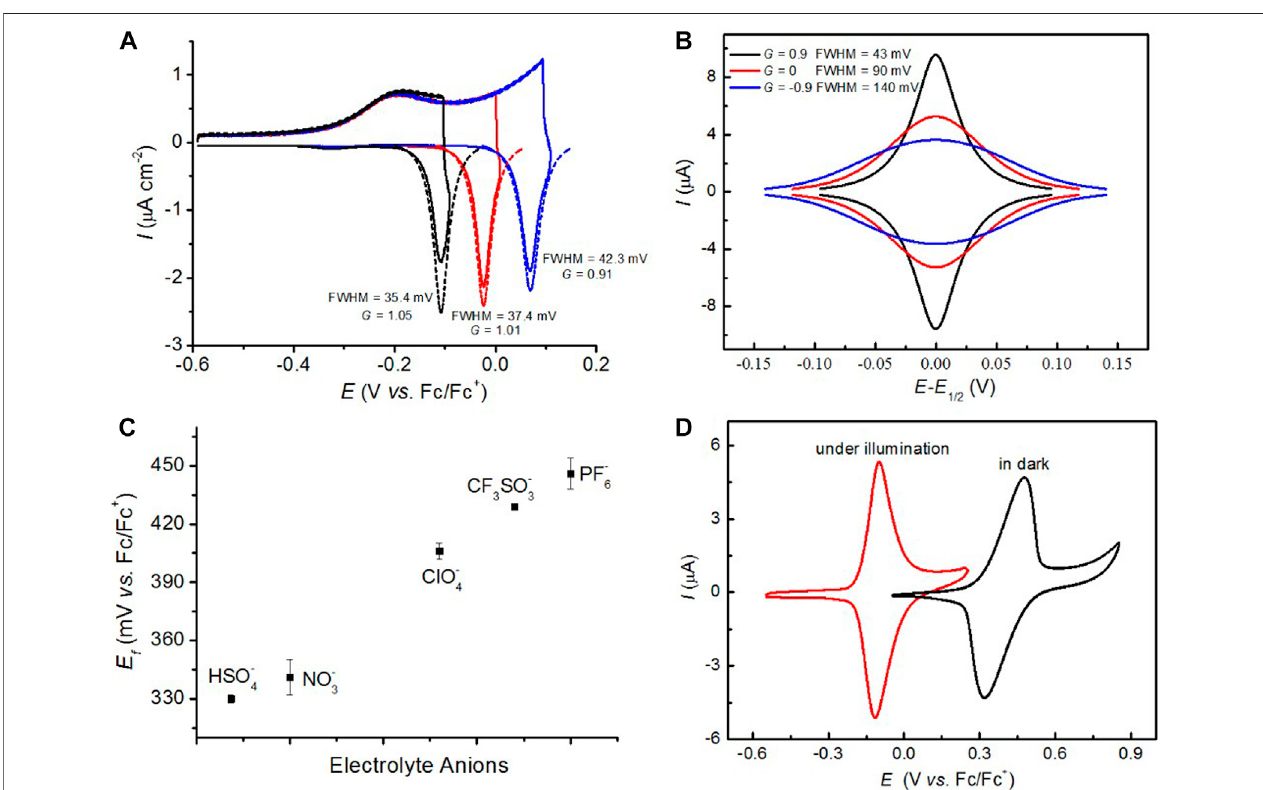
FIGURE 1 |(A) Anon-ideal “ peak inversion ” voltammogram isinduced on the TEMPO monolayer modi fi ed poorly doped Si(100) electrode when the illumination is switchedoffattheanodicvertex(0.4,0.5,or0.6 V)in0.1 Mdichloromethane/tetrabutylammoniumperchlorate(DCM/TBAClO 4 ).ThesimulatedCVs(symbol),calculated FWHMvalues,and re fi ned self-interactionparameter G arealso indicated. (B) Simulated CVs forareversible one-electron redox couplewhereboth species arestrongly adsorbed on the electrode surface. The Frumkin “ G ” term that leads tothe isotherm under equilibrium is varied between − 0.9 and 0.9, suggestingthe extent of the electrostatic interactions can be parametrized by simply introducing changes to the Frumkin G factor. The electrode area is set to 0.28 cm 2 , surface coverage is 2 × 10 − 10 mol cm − 2 ,andthevoltagesweeprateis100 mV s − 1 . (C) Shiftsoftheexperimental E 0 f asafunctionoftheLewisbasicityoftheelectrolyteanions.Theexperimental valuesof E 0 f areobtainedfrom the CVdata oftheTEMPO monolayer inacetonitrilesolutioncontainingdifferenttetrabutylammonium salts. Theindicatederror bars were calculated based on 95% con fi dence limit of the mean with six repetitive measurements for each electrolytic system. (D) CVs for TEMPO prepared on lowly doped Si(100) electrodes: redox waves in dark (black line) and their underpotential shifts under illumination (red line).